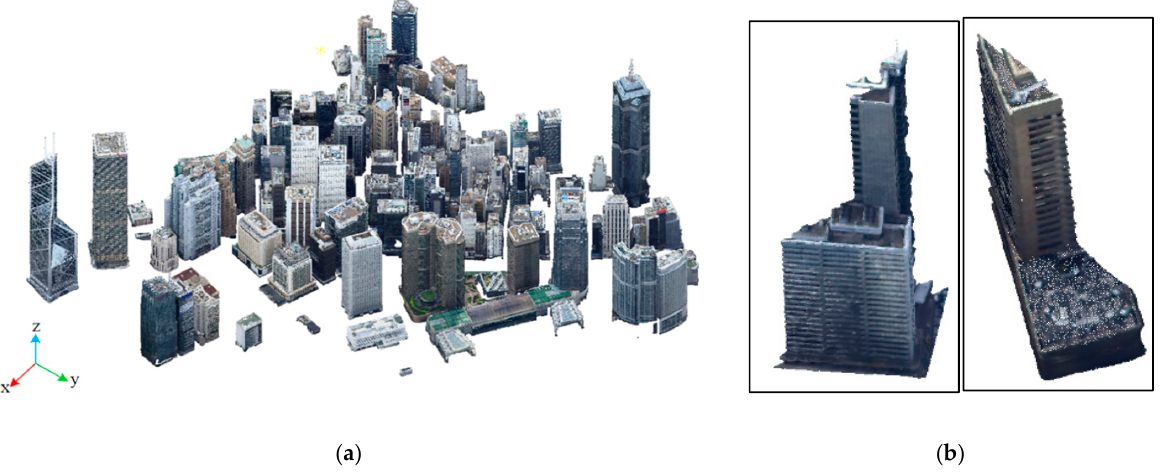
Figure 15. Building point clouds in the central area of Hong Kong. ( a ) 105 buildings with relatively complete representations; ( b ) Building point clouds at the boundaries of this area representing incomplete building shapes.